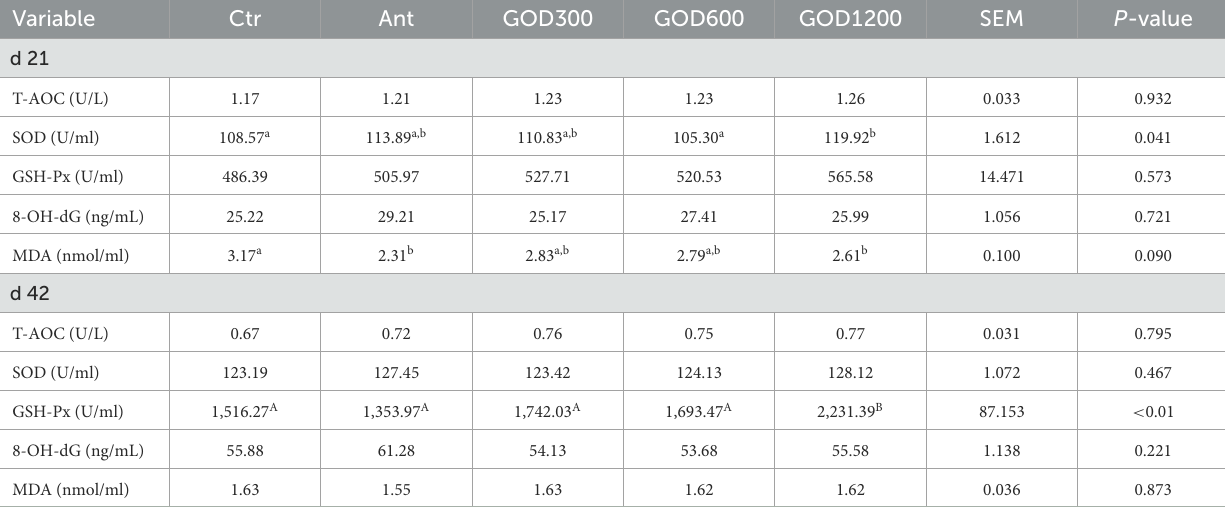
TABLE 7 Antioxidant parameters in the serum of broilers (mean ± SEM, n = 6).